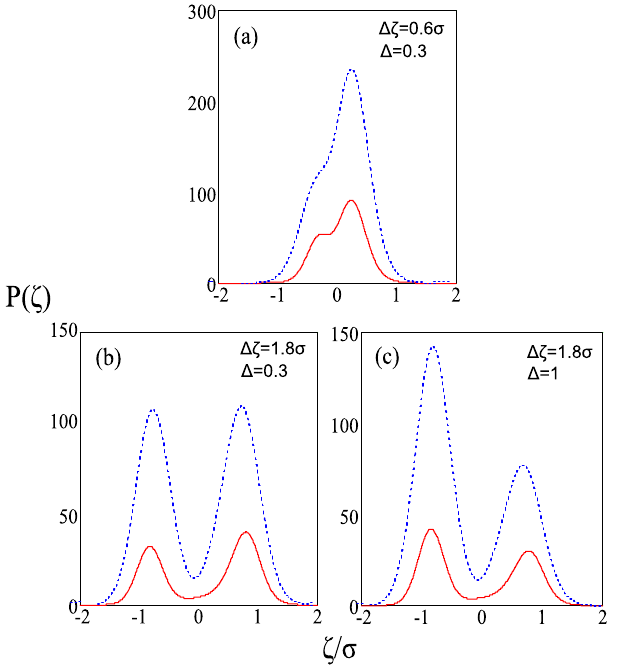
FIG. 4. Pulse amplitude (in arbitrary units) vs ζ = σ at two different positions inside the undulator z ¼ 0 . 55 · L (continuous u line) and z ¼ 0 . 65 · L (dotted line). The different plots are for u different values of the separation Δ ζ between the two peaks and slippage Δ .